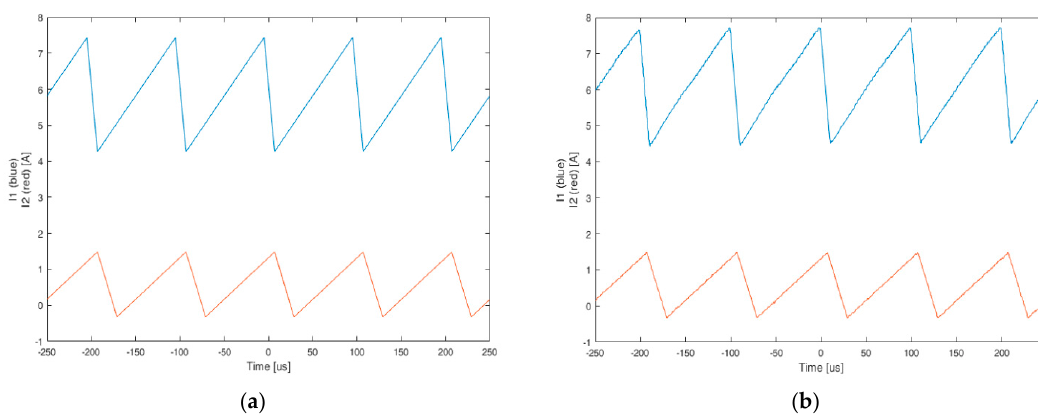
Figure 12. Current waveforms in Test 1 ( a ) simulation ( b ) experimental.